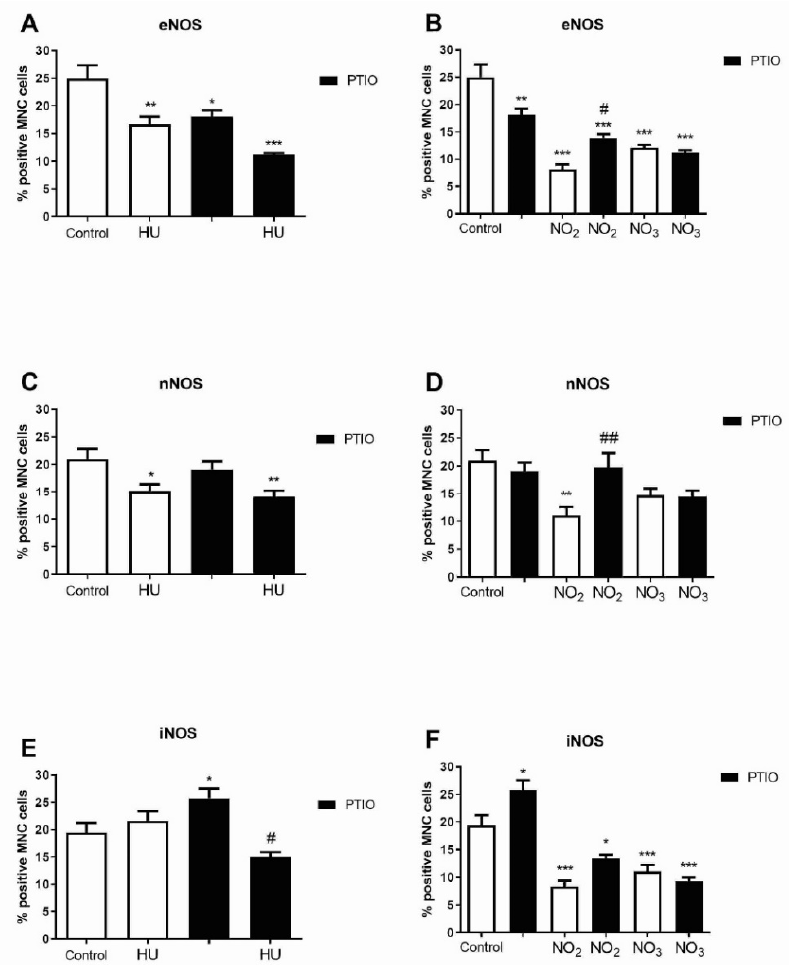
Figure 4. NOS levels in mouse bone marrow derived mononuclear cells (BMC). Frequency of eNOS ( A , B ), nNOS ( C , D ), and iNOS ( E , F ) positive BMC in mice in vivo treated with hydroxyurea (HU) ( A , C , E ), sodium nitrite (NO 2 ), and sodium nitrate (NO 3 ) ( B , D , F ), with or without PTIO. The correspond immunocytochemistry slides are in Supplemental Figure S1. Values are mean ± SEM ( n = 10). * p < 0.05, ** p < 0.01, and *** p < 0.001 vs. non-treated mice (Control); # p < 0.05, and ## p < 0.01 vs. HU or NO 2 treated only.